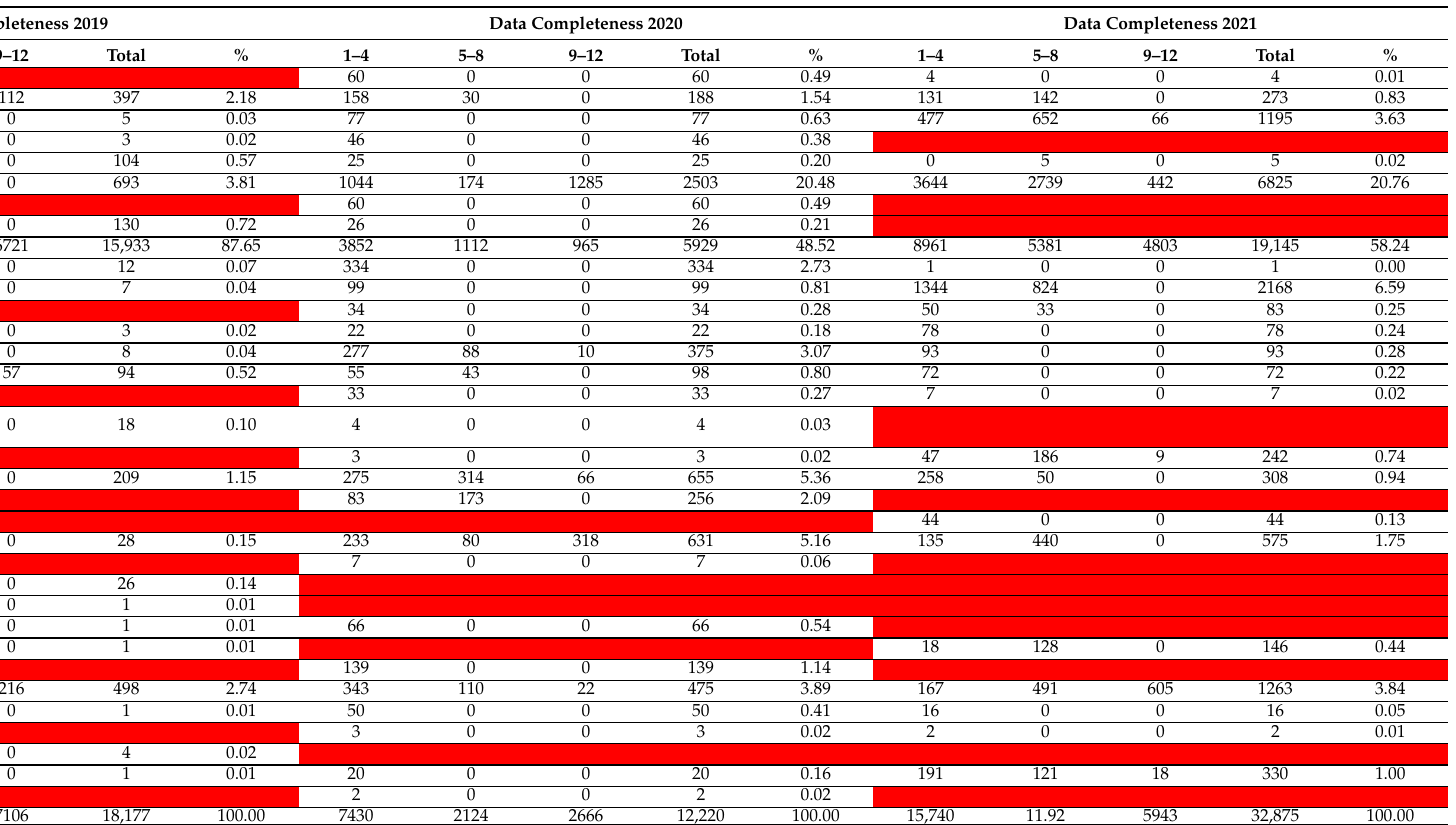
Table 3. Data completeness per province 2019–2021.